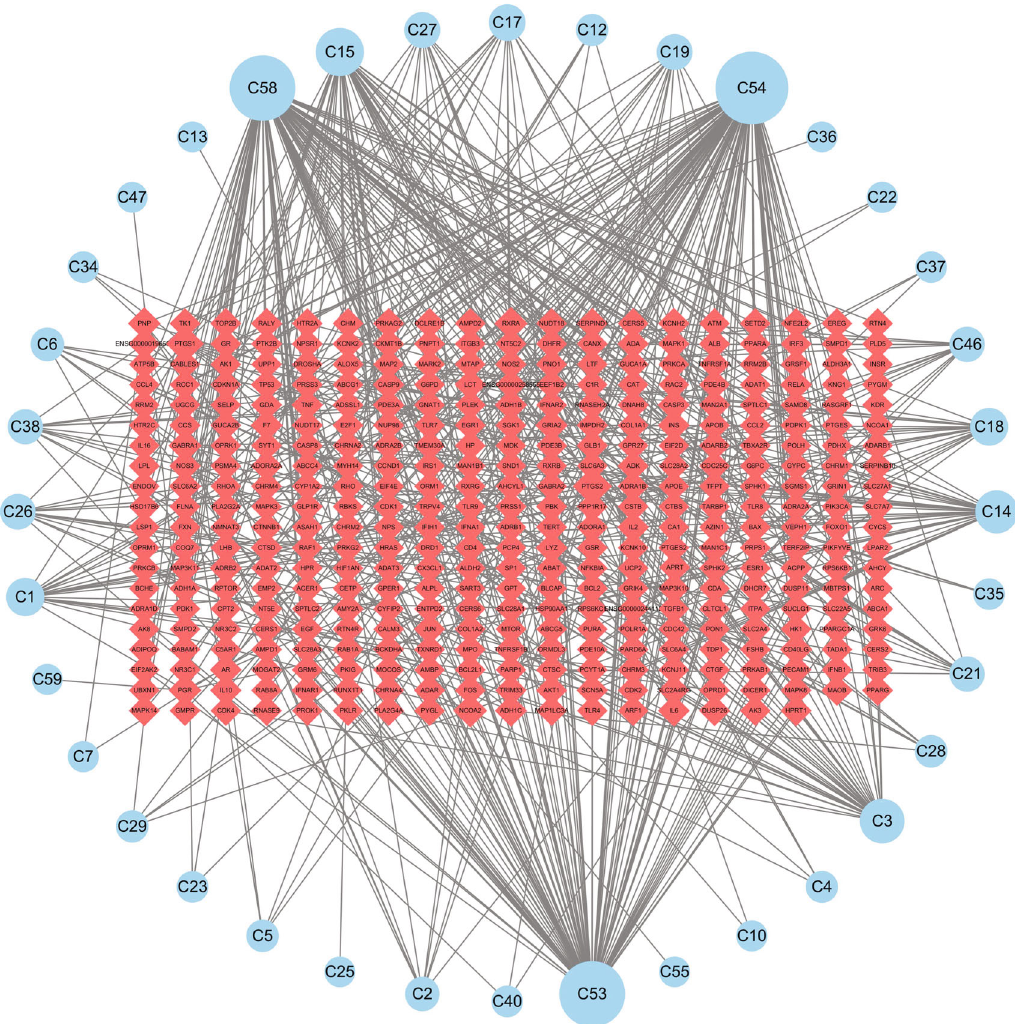
Figure 2: The active components and target network of cordyceps cicadae. The blue circle represents the component of cordyceps cicadae; the red diamond represents the target; the size of the node represents the size of the node